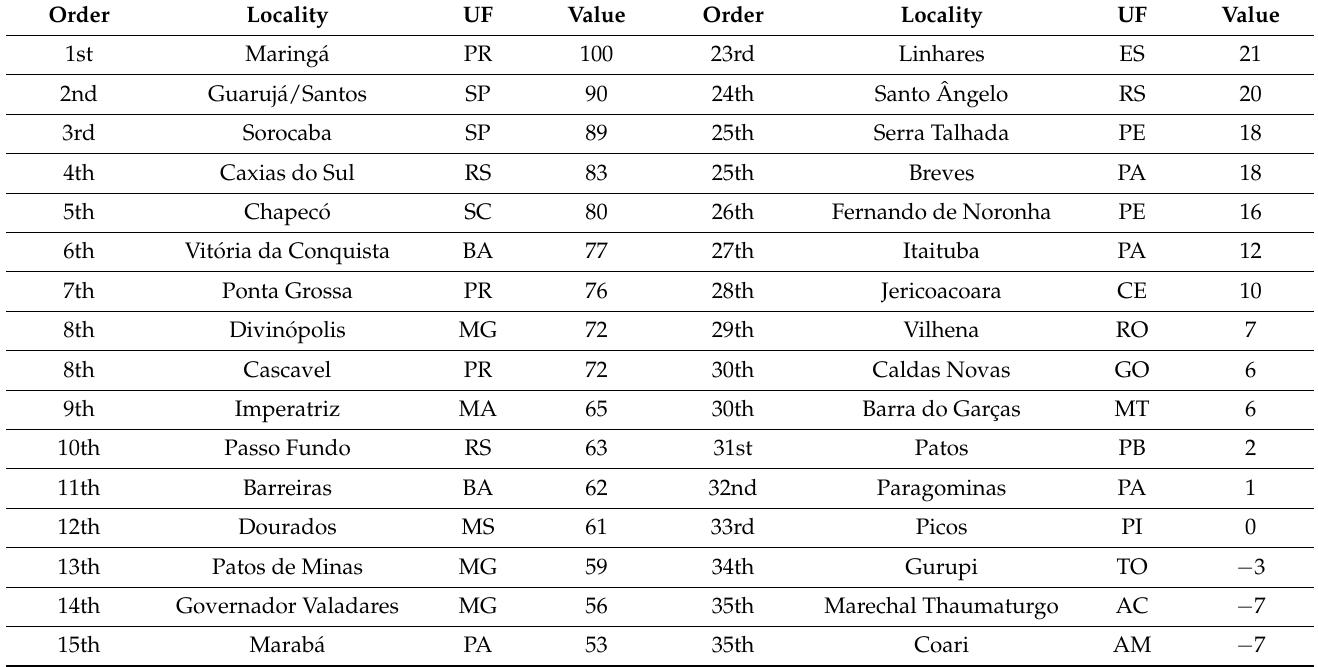
Table 10. General